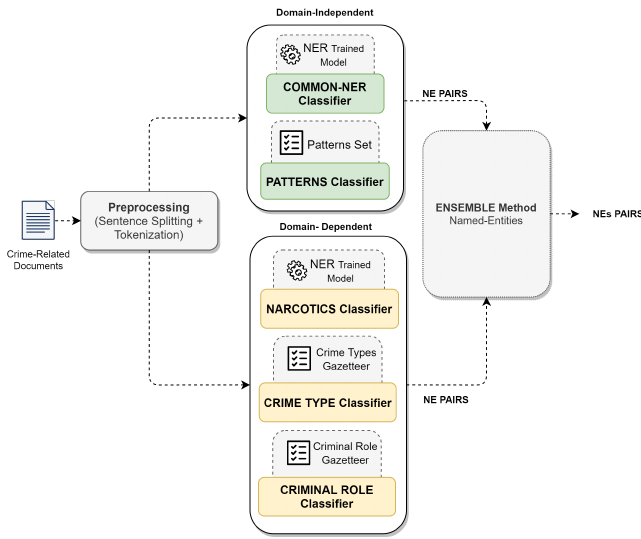
Figure 2. NER-SEMCrime Module